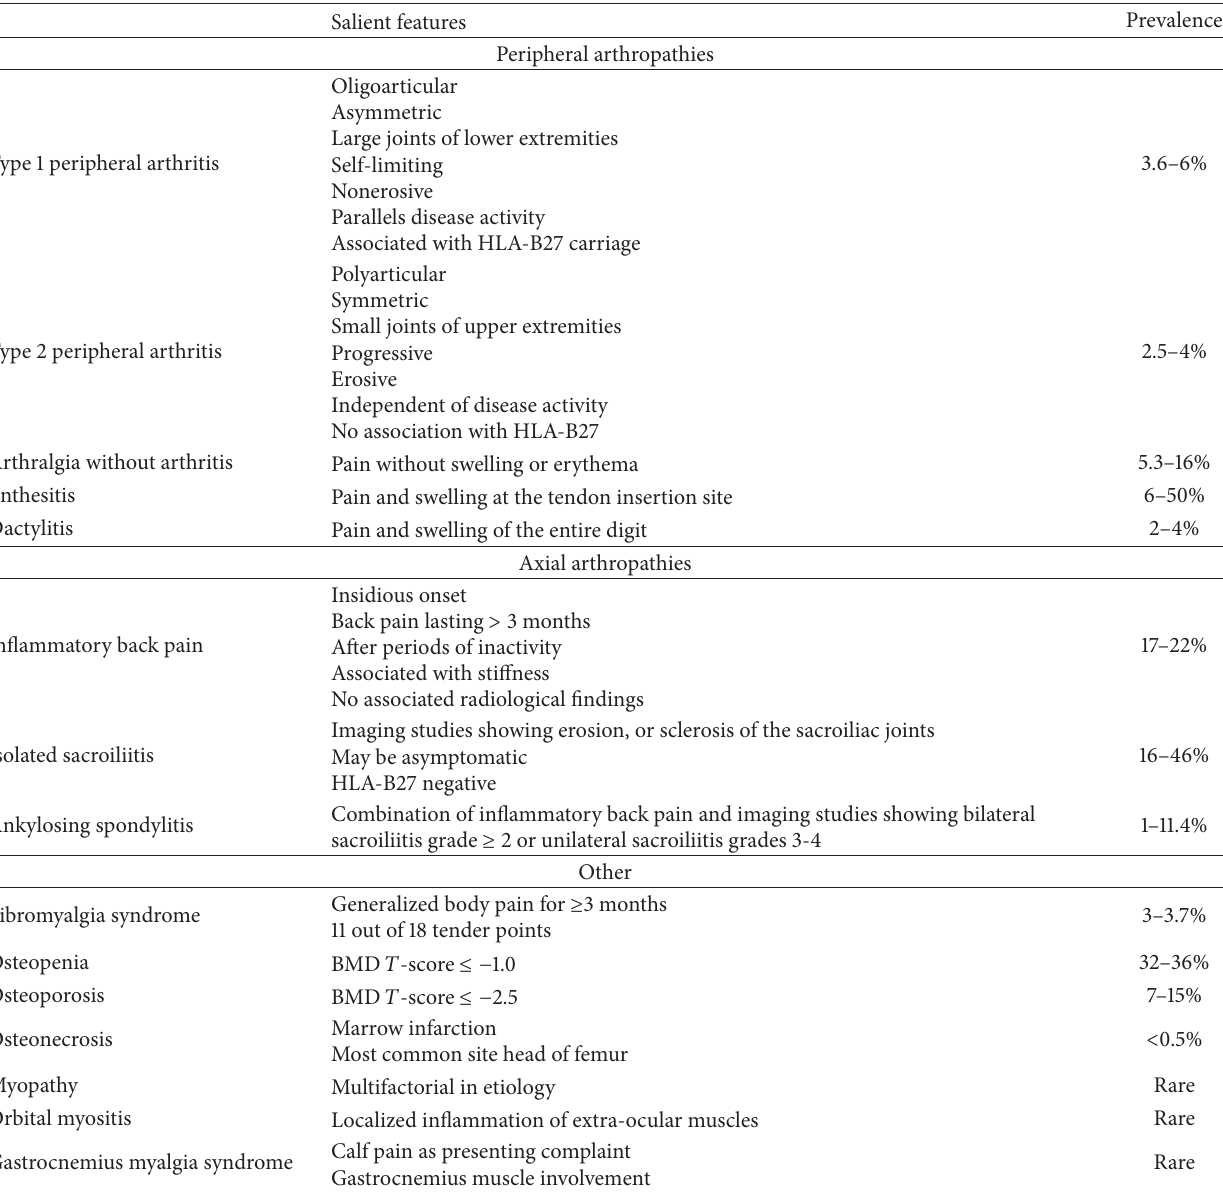
Table 2: Musculoskeletal manifestations in